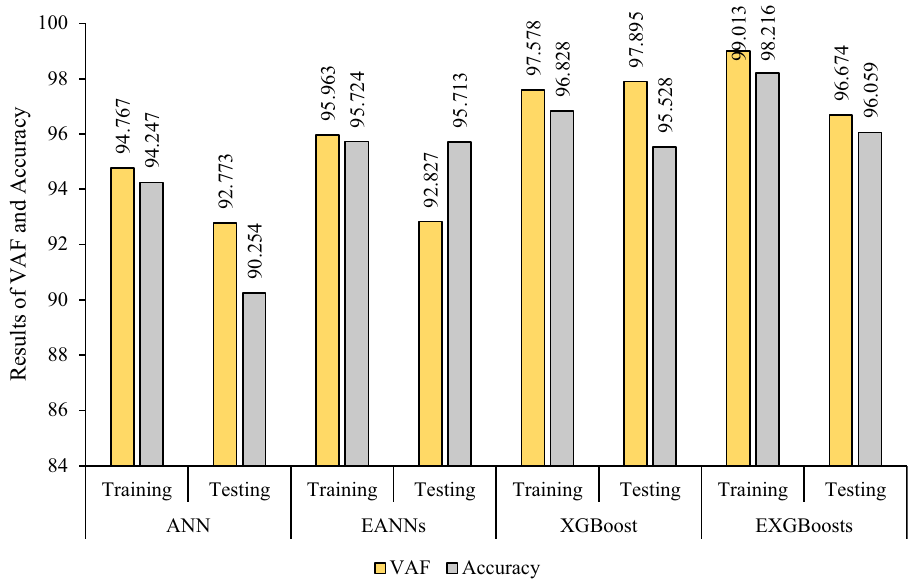
Figure 11. The value of VAF and accuracy for selecting the best model in the predicting PPV